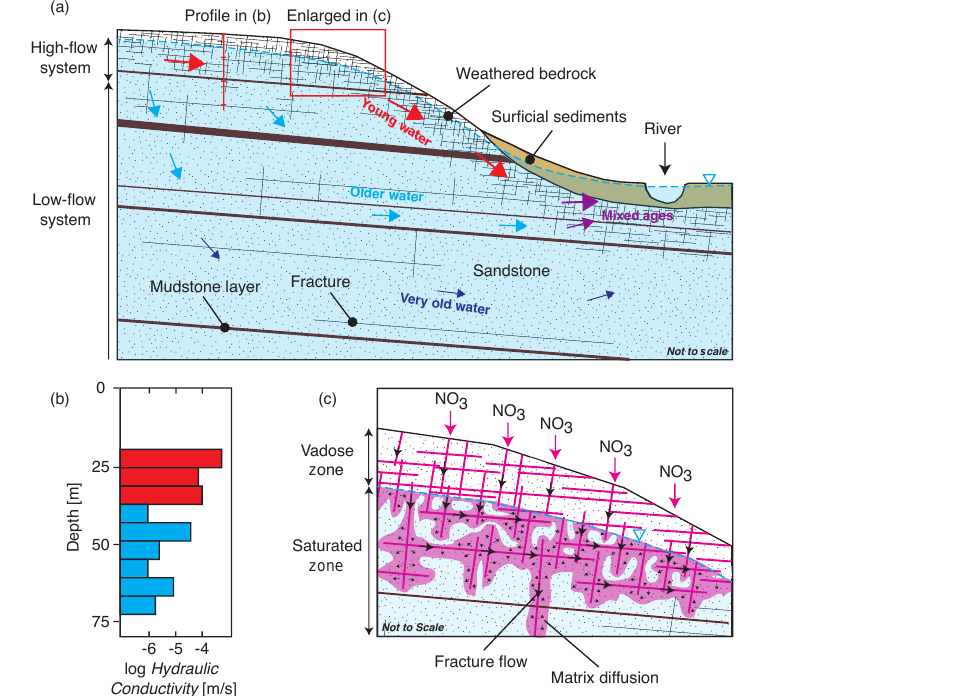
Figure 2. (a) Schematic conceptual model of the groundwater flow system along with (b) a typical profile of hydraulic conductivity showing distinct shallow high-flow (red) and deeper low-flow (blue) systems; and (c) a conceptualization of nitrate transport in the double-porosity sandstone aquifer with advective fracture flow and matrix